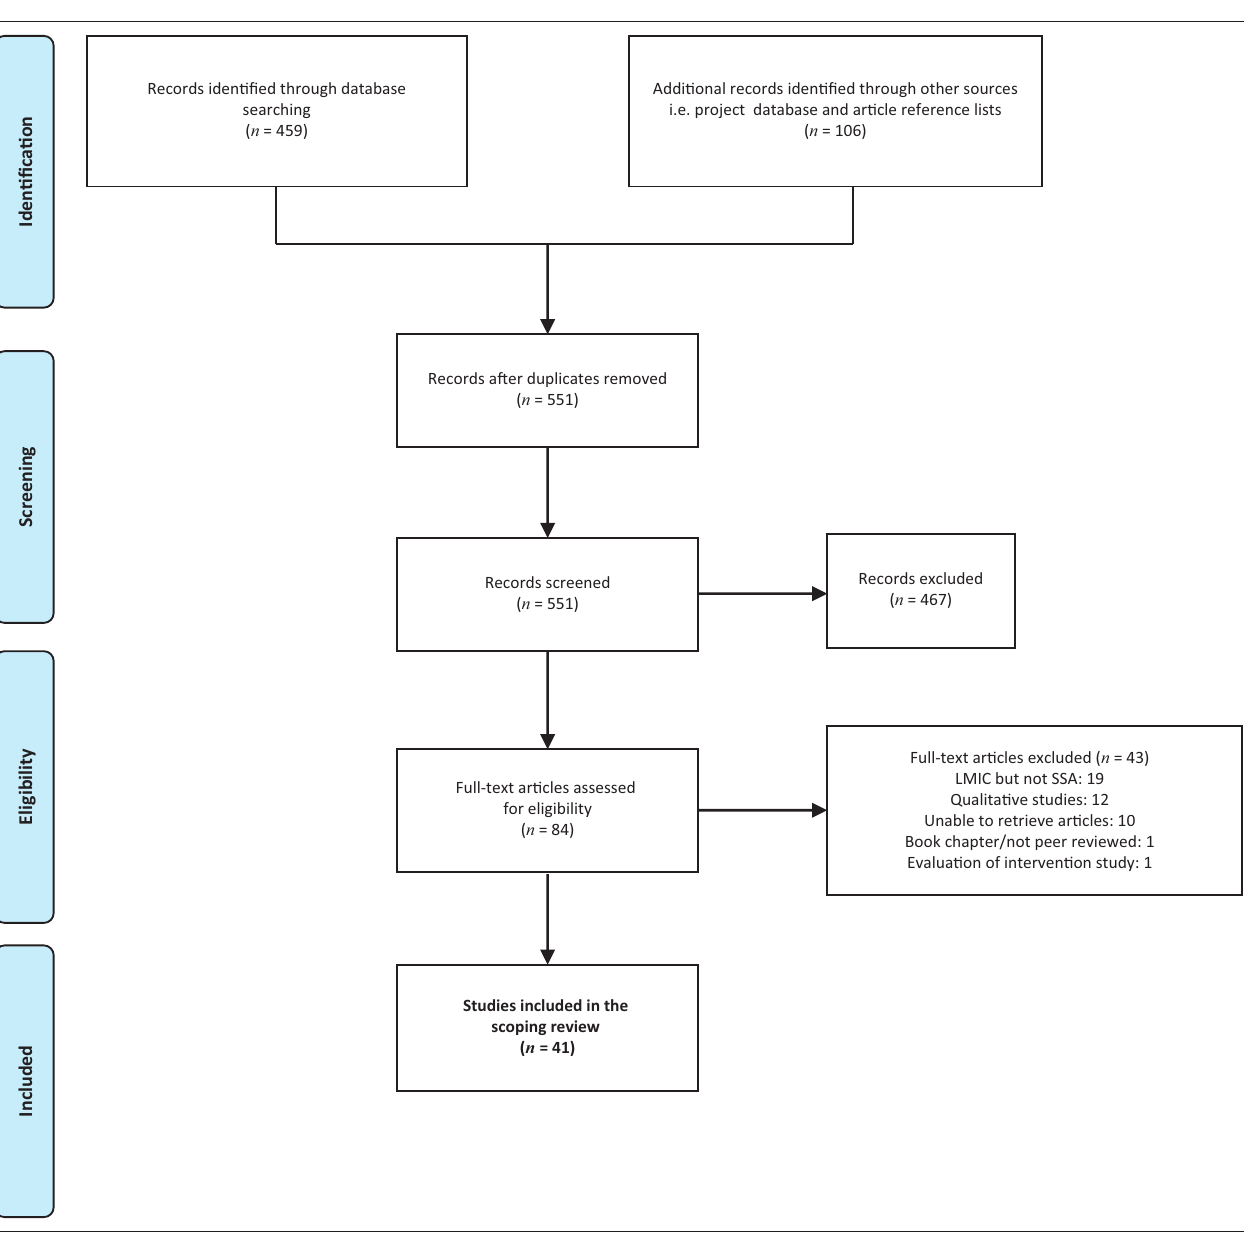
FIG URE 1: PRISMA flow diagram.